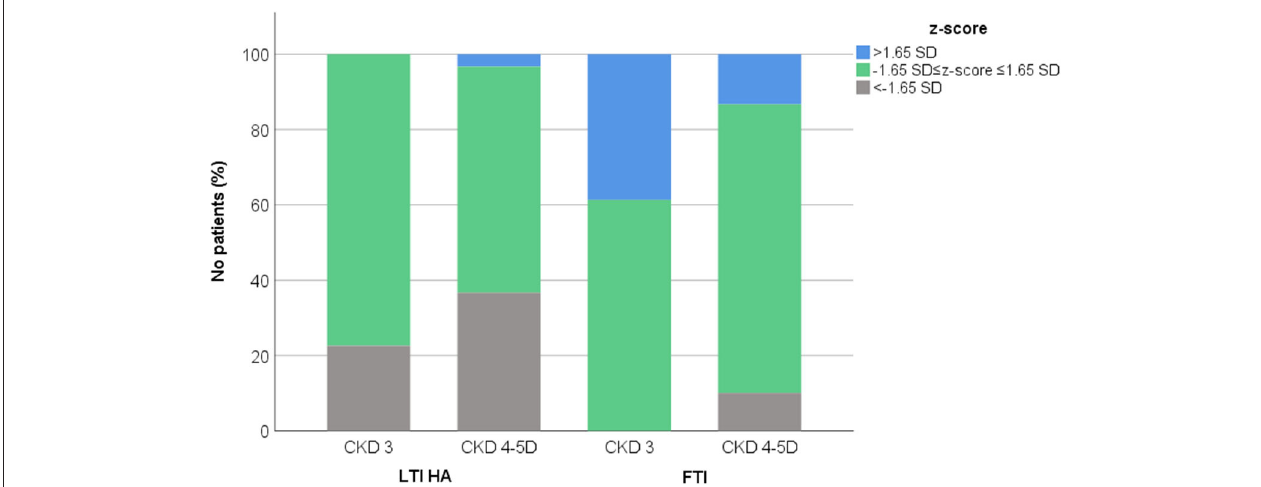
FIGURE 1 | Distribution of lean tissue index adjusted to height-age (LTI HA) and fat tissue index (FTI) z-scores in chronic kidney disease (CKD) stage 3 and 4–5D patients.